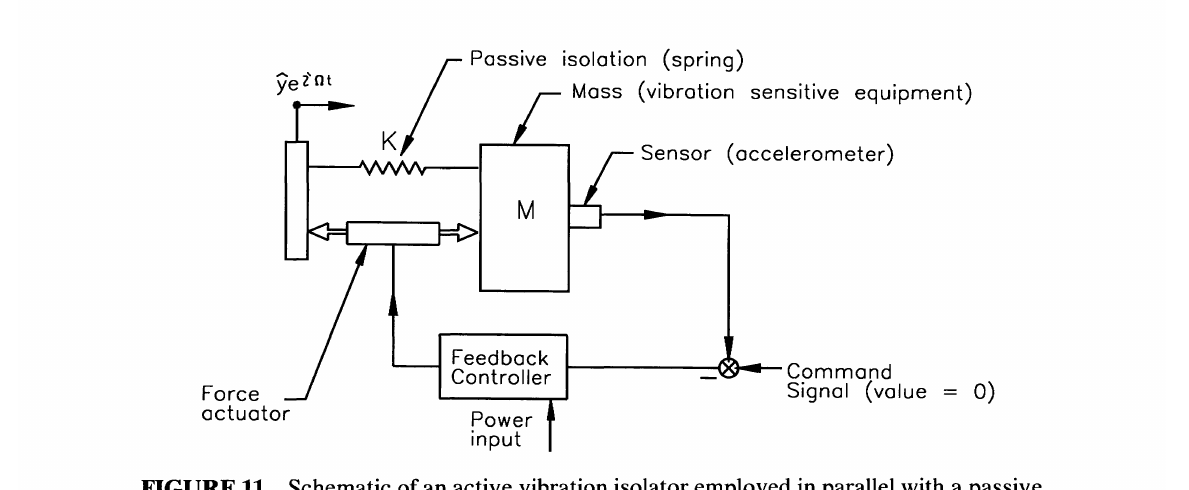
FIGURE 11 Schematic of an active vibration isolator employed in parallel with a passive isolator of stiffness